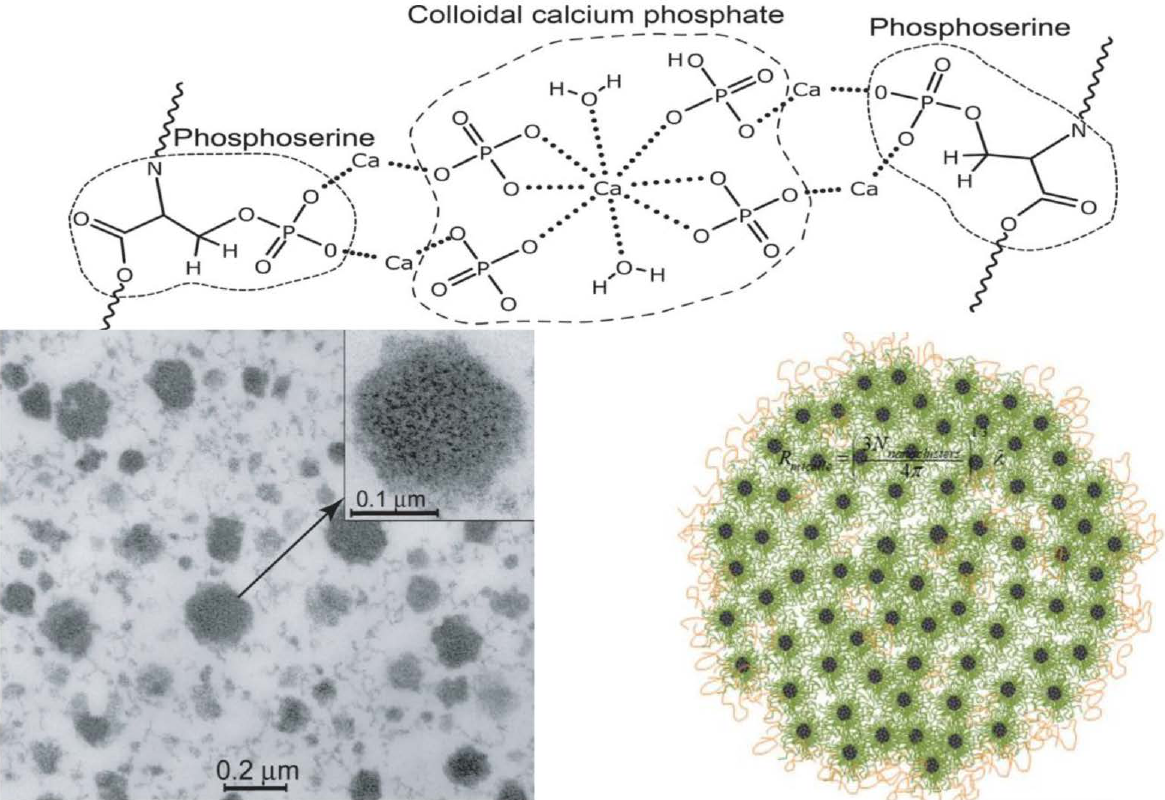
Figure 7. Postulated structure of casein micelle inter-casein linkages of phosphoserine residues to colloidal calcium phosphate. Sources: [5,82]. Reproduced with permission from